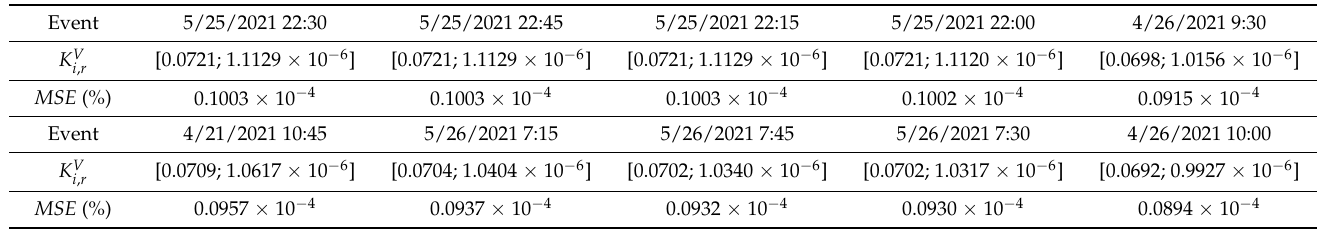
Table 4. Impact of change in active power consumption of a flexibility provider/asset (Cons30) on change in voltage at node with the lowest